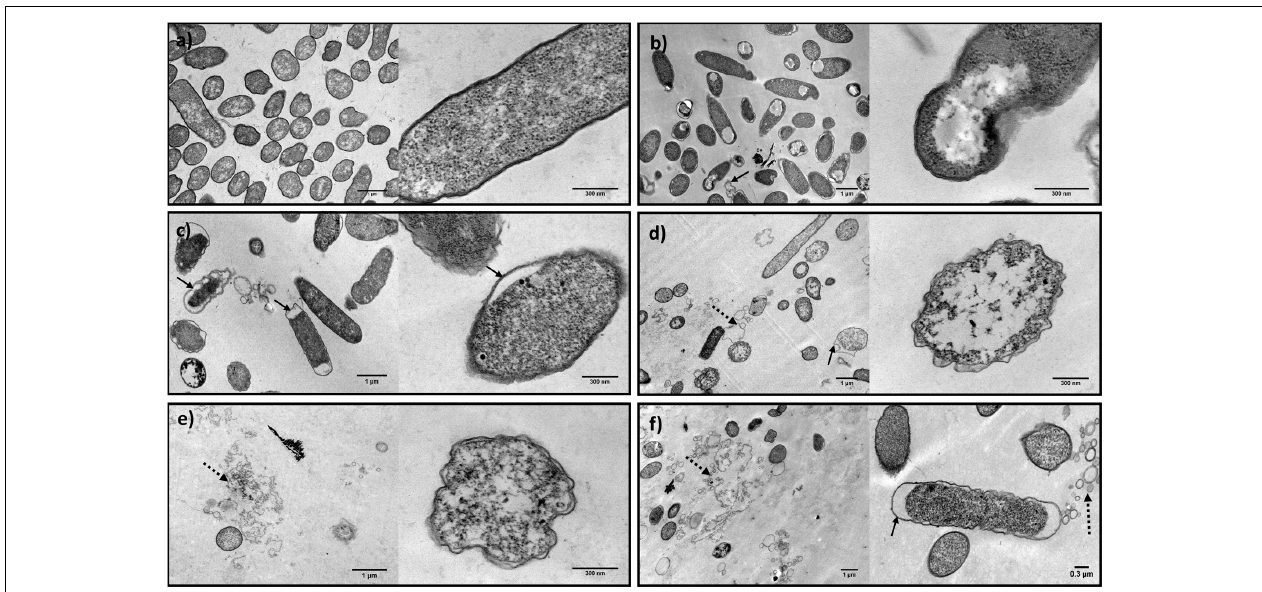
FIGURE 6 | TEM micrographs showing the effect of honey, phage, and honey–phage combination treatments in E. coli cells. (a) Control E. coli , (b) PF2 25% , (c) U3 25% , (d) EC3a phage at a MOI 10, (e) phage–PF2 25% at a MOI 10, (f) phage–U3 25% at a MOI 10 (arrows indicate membrane detachment and dashed arrows point cell